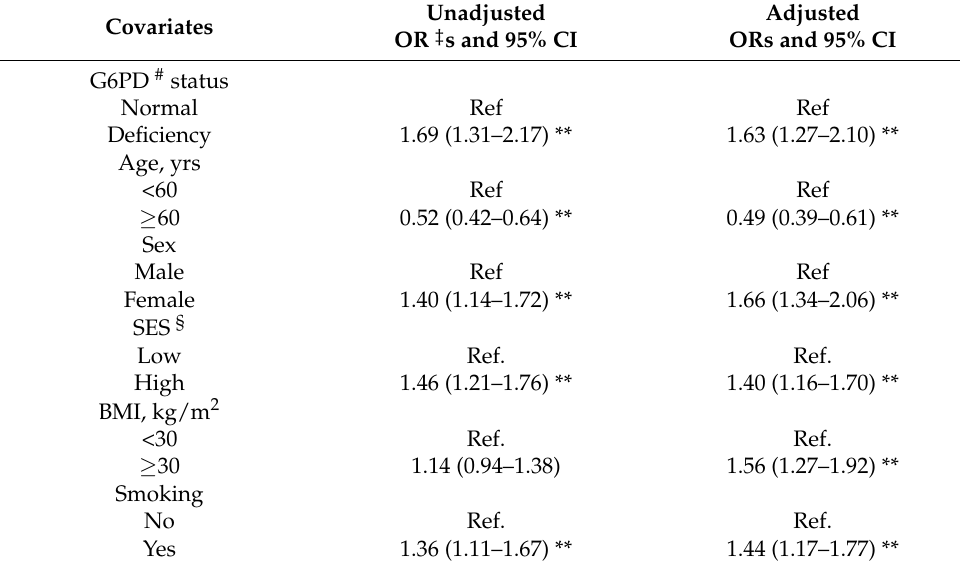
Table 3. Logistic regression analysis for G6PD status and other variables potentially associated with the risk of asthma.